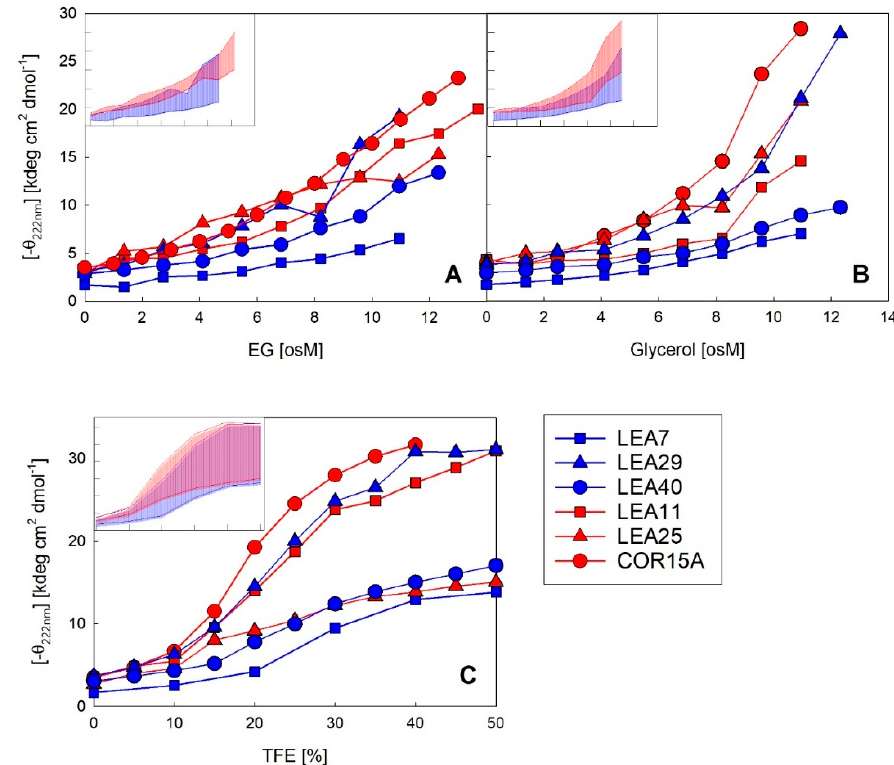
Figure 8. Increase in α -helicity plotted as negative ellipticity at 222 nm of the six LEA_4 family proteins as a function of EG ( A ), glycerol ( B ) and TFE ( C ) concentration. The datasets for COR15A in the presence of all three solutes and for LEA11 and LEA25 in glycerol and TFE have been published previously [30,33]. Insets show the variance in negative ellipticity at 222 nm of the two LEA_4 clades. Highest and lowest ellipticity at 222 nm within the LEA_7 clade (blue) and COR15A clade (red) represent the limits of the colored areas. Axis labels and scales are identical to the corresponding full-size panels.